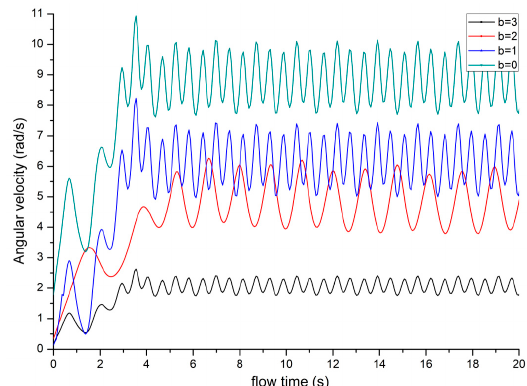
Figure 8. Time-domain curves of angular velocity at different load factors.